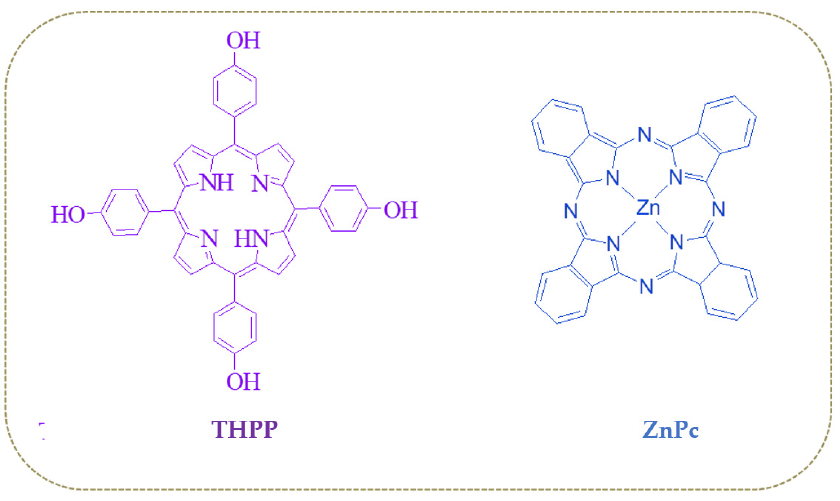
Figure 1. Chemical structures of the sensing film compositions: THPP porphyrin and ZnPc phthalocyanine. THPP and ZnPc solutions were analyzed by UV-Vis 1780 spectrophotometer (SHI- MADZU, Kyoto, Japan). In addition, THPP, ZnPc powders and the blend film deposited on the glass were characterized by X-ray diffraction (XRD, Kyoto, Japan DPMax 2400) equipped with graphite-monochromatized CuK α radiation ( λ = 1.5418 Å), angle: 10–80 ◦ , and X-ray Photoelectron Spectroscopy (XPS) with chromatic Al K α source (12.5 mA, 12 kV) at pressure as 2 × 10 − 10 Torr, respectively. The deconvolution of the XPS spectra was operated by Fityk software (Microsoft, GitHub, San Francisco, CA,